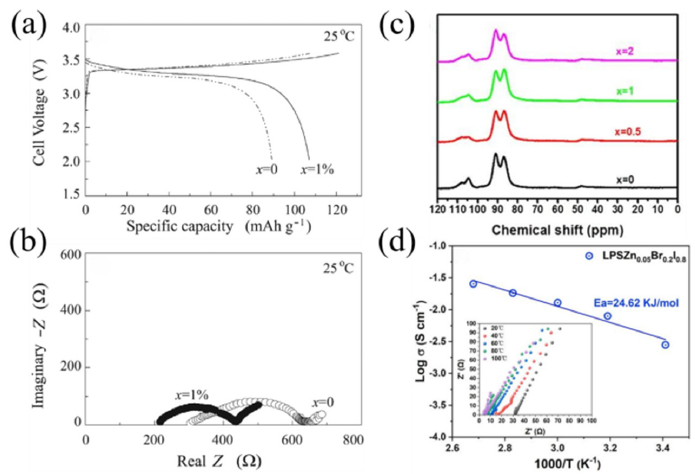
Figure 7. ( a ) Charge and discharge curves of Li-In/70Li 2 S-(30 − x)P 2 S 5 -xLi 3 PO 4 /LiCoO 2 battery; ( b ) electrochemical impedance spectra of Li-In/70Li 2 S-(30-x)P 2 S 5 -xLi 3 PO 4 /LiCoO 2 battery. Reprinted with permission from ref. [100]. Copyright 2019 Elsevier. ( c ) The 31 P MAS NMR spectra of (100 − x)(70Li 2 S-30P 2 S 5 )-xFeS 2 (x = 0, 0.5, 1, 2) glass-ceramic samples. Reprinted with permission from ref. [107]. Copyright 2020 Elsevier. ( d ) Conductivity and impedance data for LPSZn 0.05 Br 0.2 I 0.8 glass-ceramic SSEs. Reprinted with permission from ref. [115]. Copyright 2022 Elsevier.